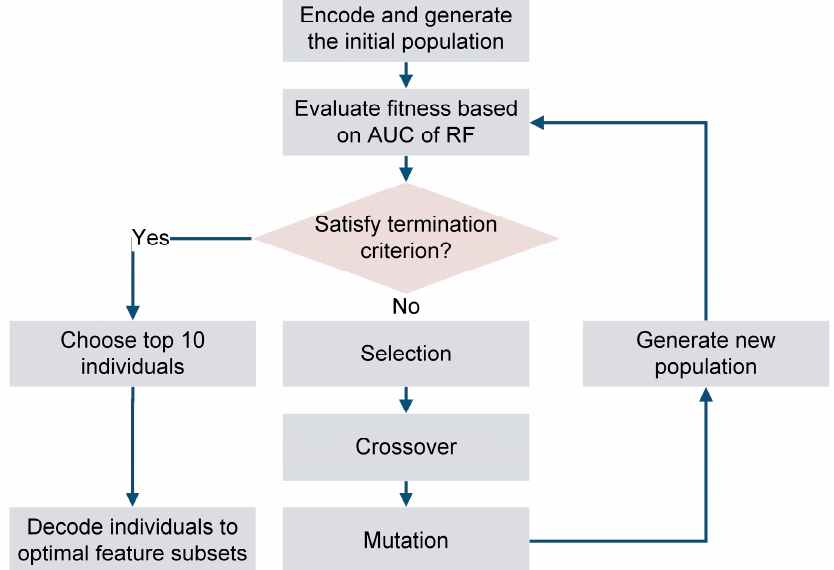
Figure 1. The flowchart of the GA-RF (genetic algorithm-random forest) algorithm.